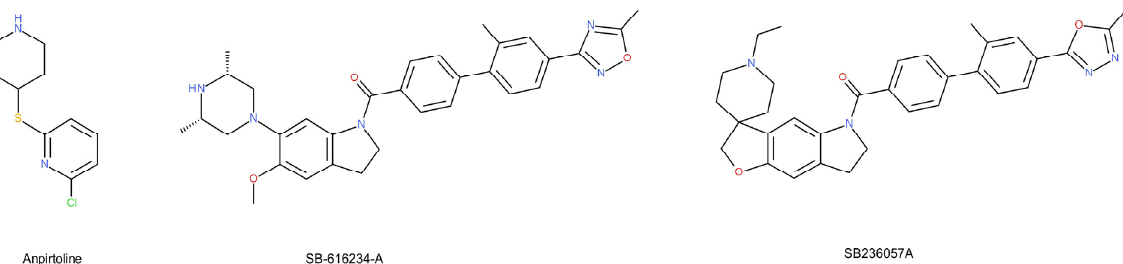
Figure 4. 5-HT 1B receptor ligands: anpirtoline, SB-616234-A, and